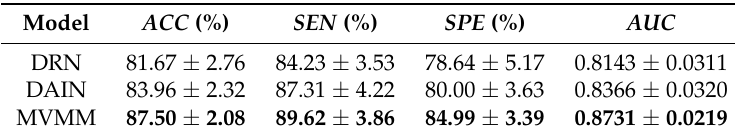
Table 2. Classification performance of different views for T1 task.